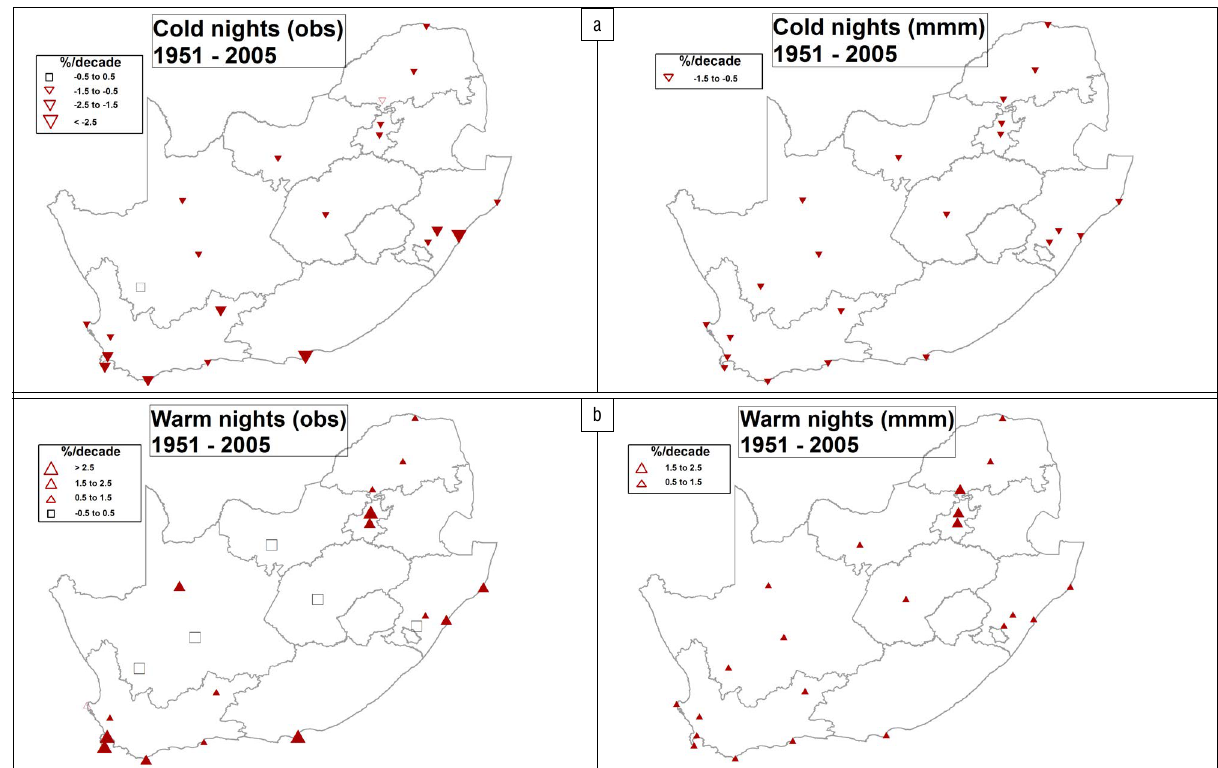
Figure 3: Trends in annual number of (a) cold nights (TN10P) and (b) warm nights (TN90P), in % per decade, for the period 1951–2005 from the observations (obs) and multi-model mean (mmm) data sets. Filled triangles denote significant trends at the 5%